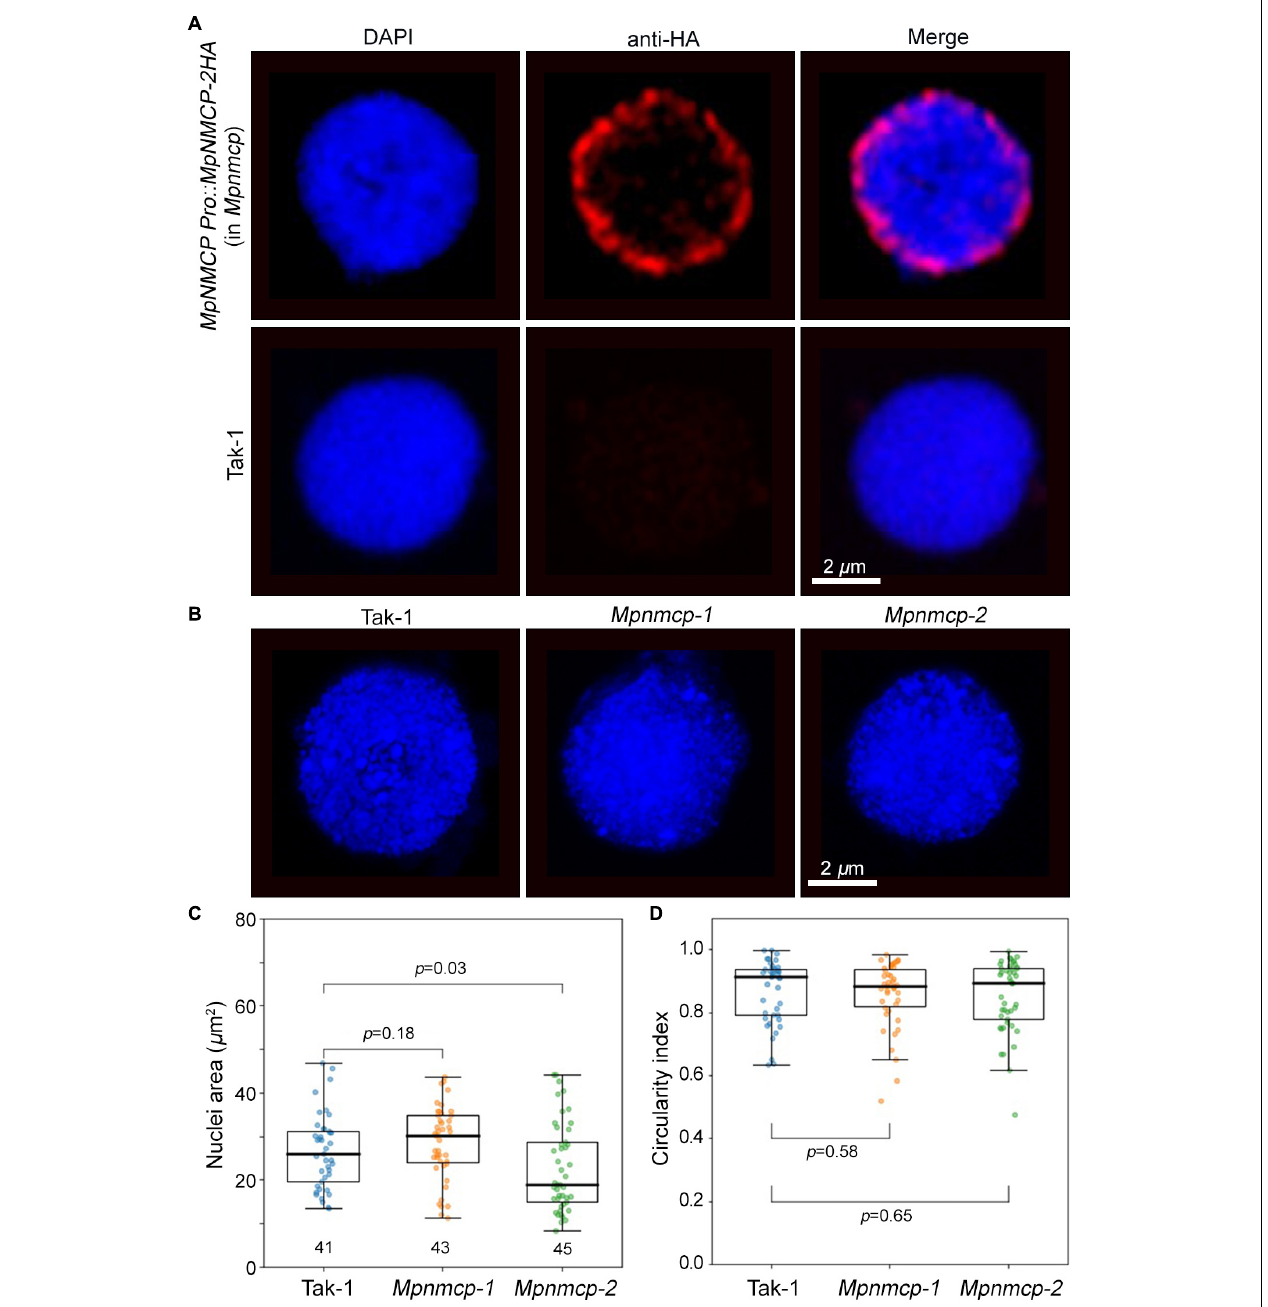
FIGURE 3 | Mpnmcp mutants do not show observable defects in nuclear morphology. (A) Immunohistostaining shows perinuclear localization of MpNMCP:2HA proteins (red, top panel). The image shown in the bottom panels serves as a negative control. 4 (cid:48) ,6-Diamidino-2-phenylindole (DAPI) staining (blue) was used for visualizing nuclei. Scale bar shows 2 µ m. (B) Representative Takaragaike-1 (Tak-1) (left) and Mpnmcp (middle and right-hand panels) nuclei stained with DAPI. (C,D) Comparison of nuclear morphology. For each genotype, measurements were taken from the maximum z-projected images of around 45 nuclei collected from gemmae to compute their nuclear size (C) and circularity index (D) . p values were determined using Mann–Whitney U